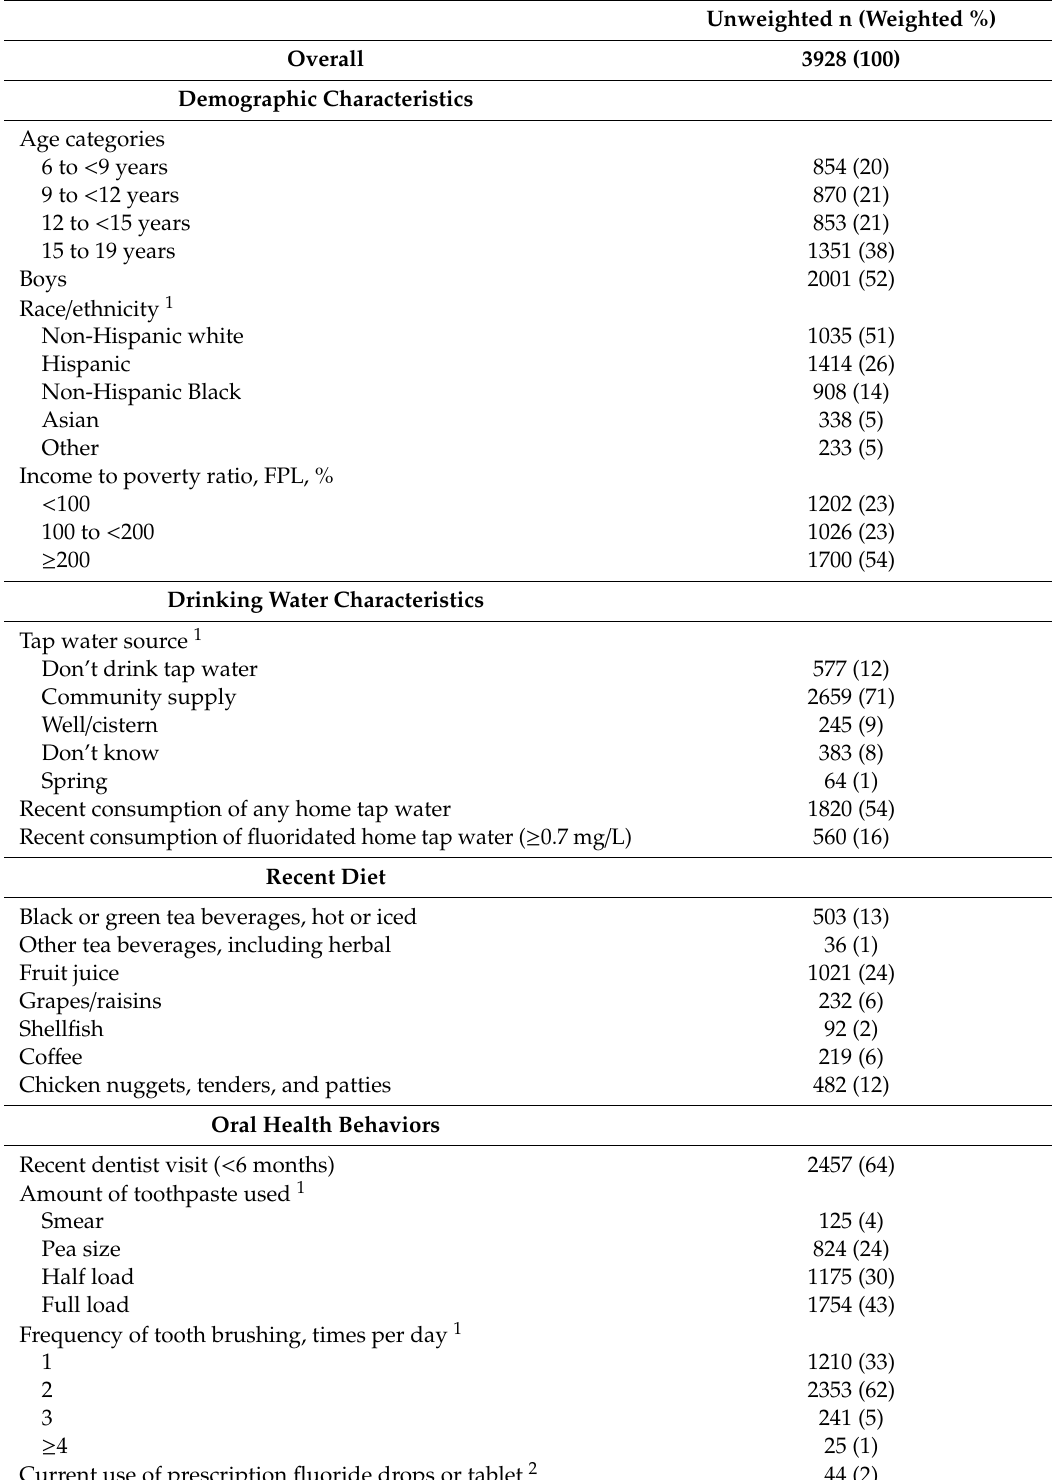
Table 1. Demographic characteristics and dietary and behavioral factors of 6–19-year-old participants (n = 3928), National Health and Nutrition Examination Survey,